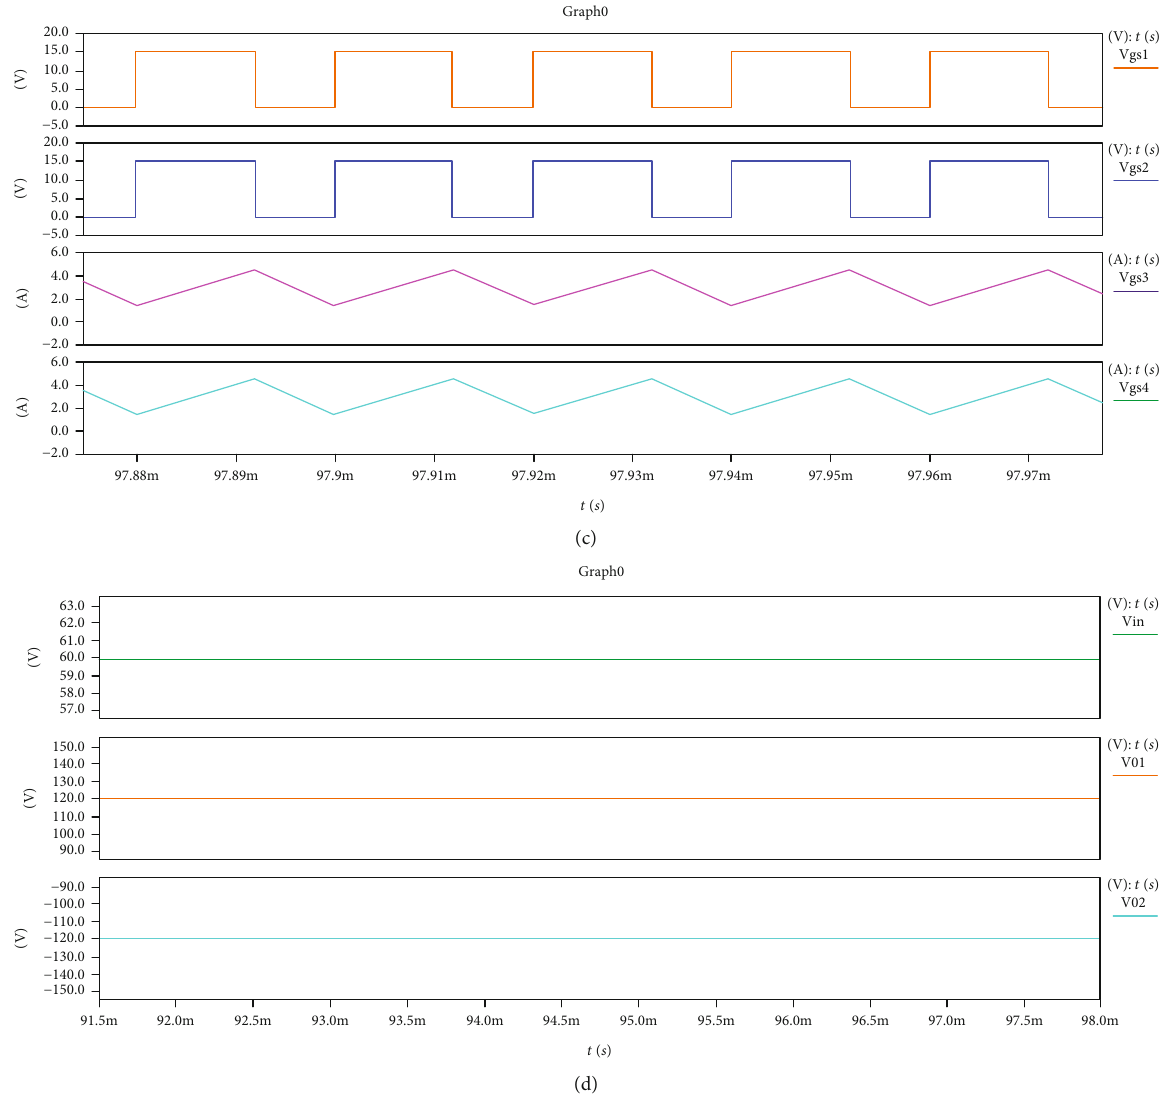
Figure 11: Simulation waveforms. (a) V